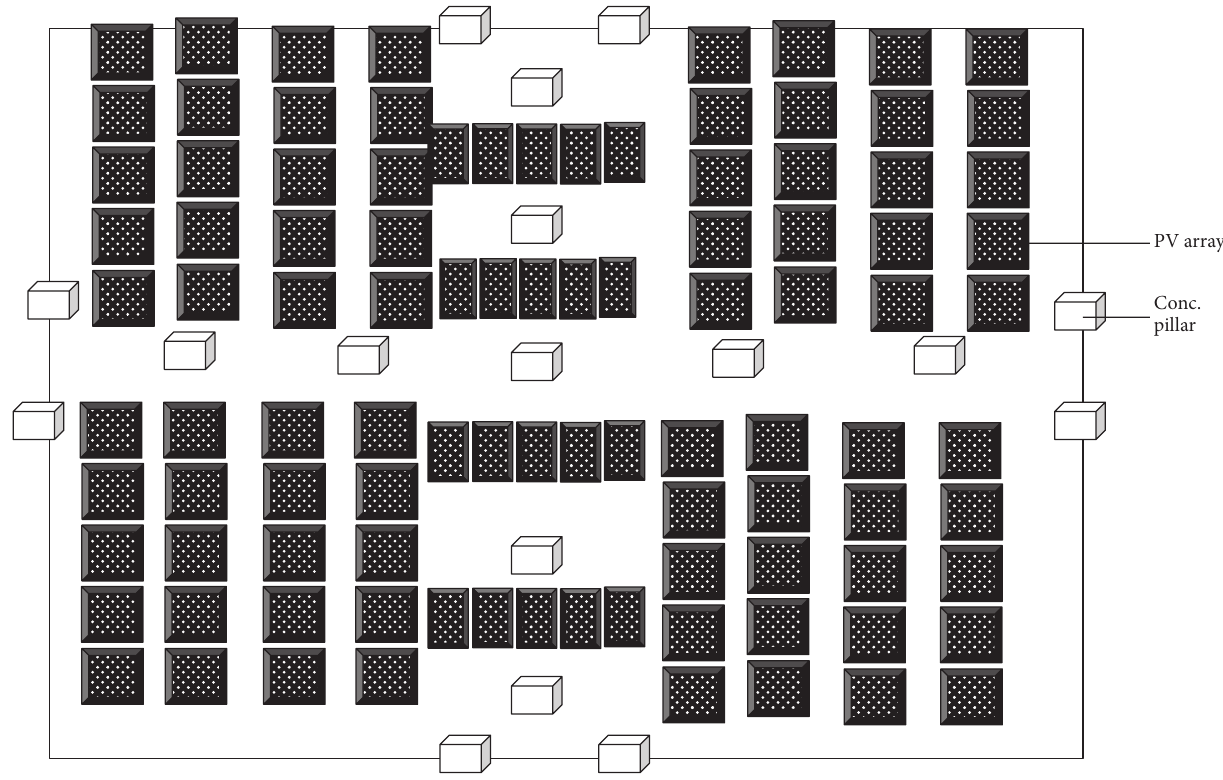
Figure 14: Aerial view of the solar farm.